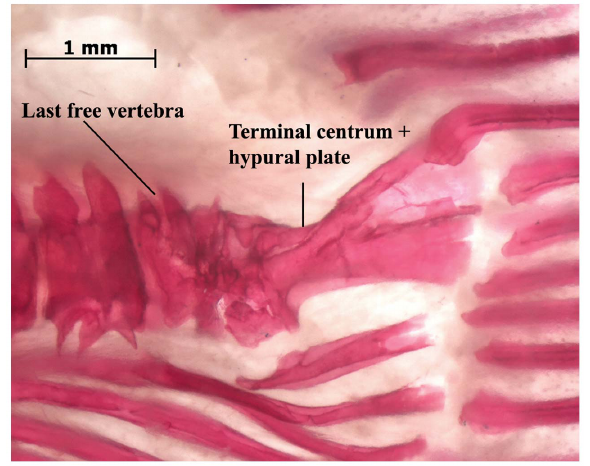
Figure 4. Photographic image of cleared and stained caudal-fin region in Electrophoruselectricus , MPEG 5370, 460 mm